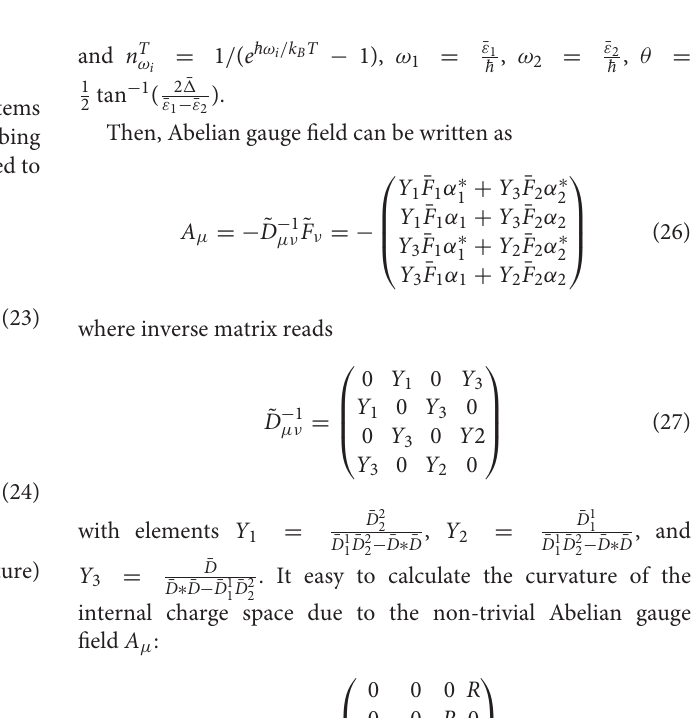
2 ps , T 1 2100 K , ε 1 = =